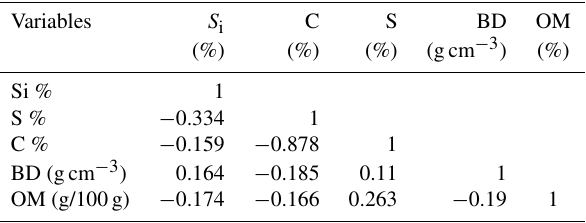
The values in bold differ from 0 to a level of significance α = 0.05, Si: silt, S: sand, C: clay, BD: bulk density, OM: organic